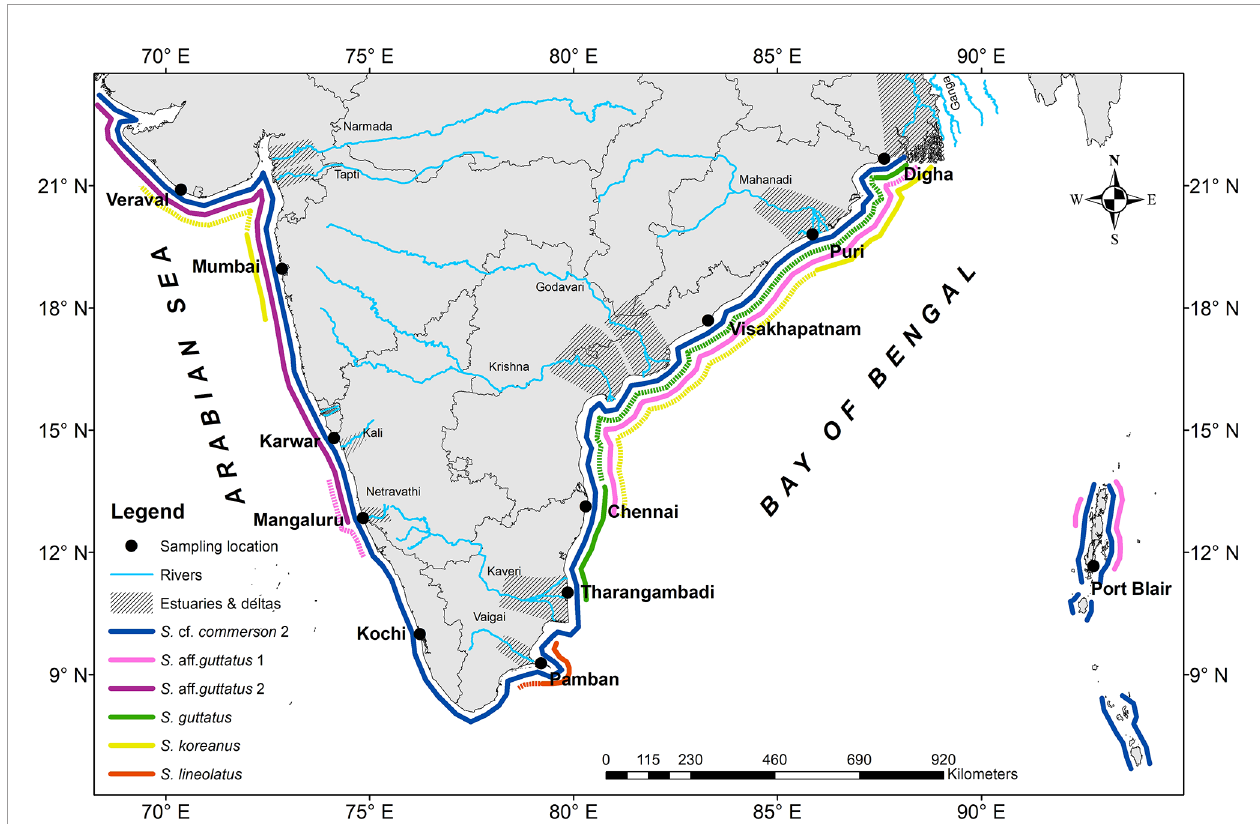
FIGURE 6 | Geographical distribution of Scomberomorus spp. in the northern Indian Ocean based on the present study. The intense and sparse distribution of each MOTU is indicated by thick and dotted lines,